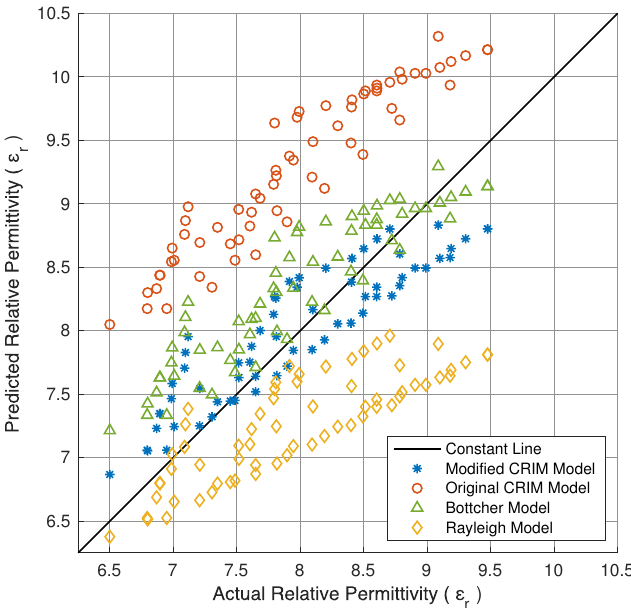
Figure 6. Comparison between different mixing models and the new modified CRIM model. The actual relative permittivity is based on the FDTD algorithm and the predicted relative permittivity is from the mixing